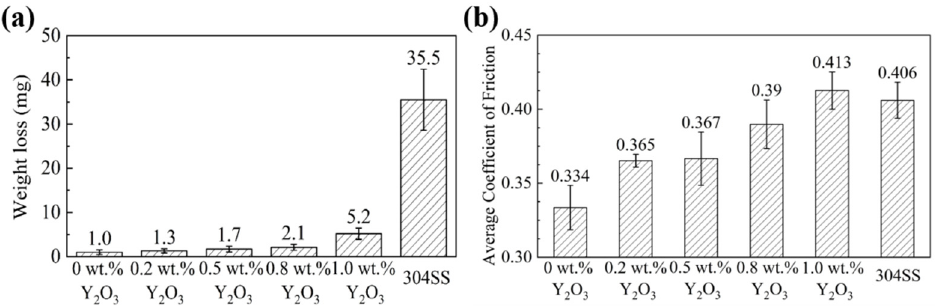
Figure 8. The results of 400 °C wear tests of the coatings and substrate: ( a ) weight loss; ( b ) average coefficient of friction.